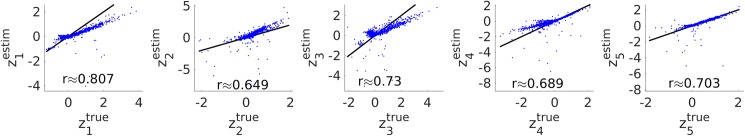
State estimates for ML solution (cf. Fig 5) from the full EM algorithm on the working memory model.In this example, true and estimated states were nicely linearly related, although mostly with regression slopes deviating from 1 (see text for further discussion). State estimation in this case was performed by inverting only the single constraint corresponding to the largest deviation on each iteration (see Methods). Bisectrix lines in black indicate identity.